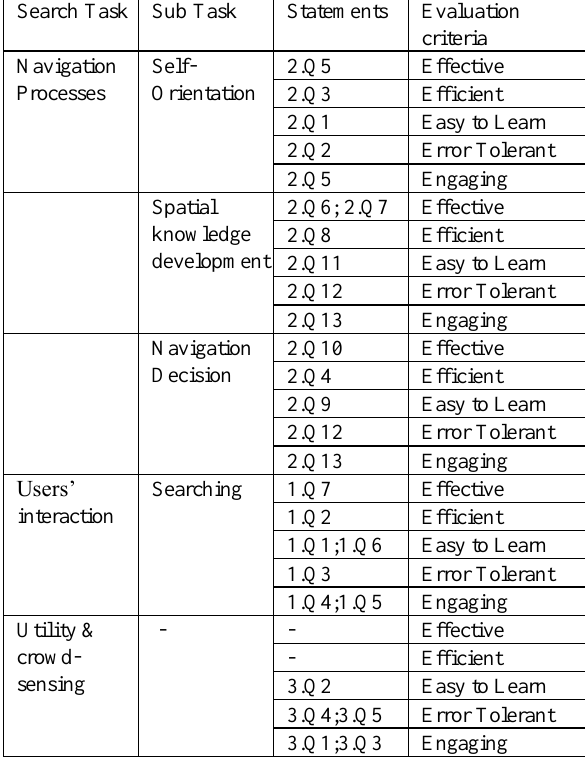
Table 1. Observing user interactions and user activities for assessing usability attributes of a pedestrian navigation